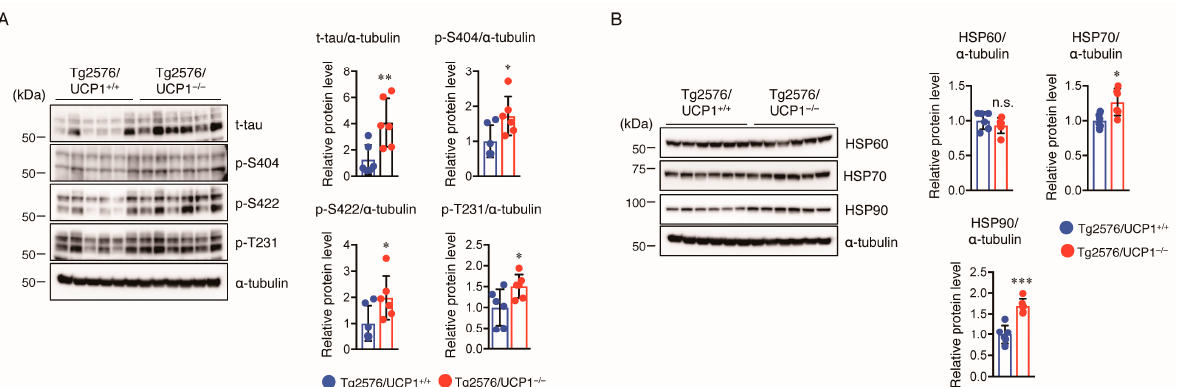
Figure 4. UCP1 deletion in Tg2576 mice increases levels of total tau, phosphorylated tau, and heat shock proteins in the cortex of brain. (( A ), left panel) Representative immunoblots showing the cortical levels of total- (t-) and phosphorylated- (p-) tau on multiple sites (Ser404, Ser422, and Thr231), and α -tubulin in 17-month-old Tg2576/UCP1 +/+ and Tg2576/UCP1 -/- mice (left panel). (( A ), right panels) Relative protein levels quantified by densitometry. (( B ), left panel) Representative immunoblots showing the cortical levels of HSP60, HSP70, HSP90, and α -tubulin in 17-month-old Tg2576/UCP1 +/+ and Tg2576/UCP1 -/- mice. (( B ), right panels) Relative protein levels quantified by densitometry. The results shown are mean ± SD, n = 6 for each group, * p < 0.05, ** p < 0.01, *** p < 0.001 vs. Tg2576/UCP1 +/+ , n.s., no significant difference, as determined by Student’s t -test.